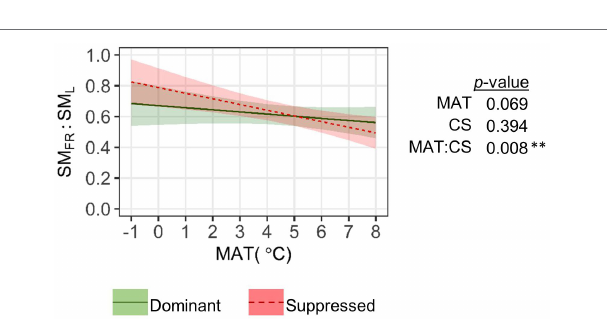
FIGURE 7 | Relationship between mean annual temperature (MAT) and the ratio of total content (sum of EIC peak areas) of secondary metabolites in fine roots (SM FR ) to leaves (SM L ). Leaf data for each sample tree were averaged across two canopy positions. The significance of the factors (MAT; CS, competitive status) according to LMM is shown next to the graph: ** p <